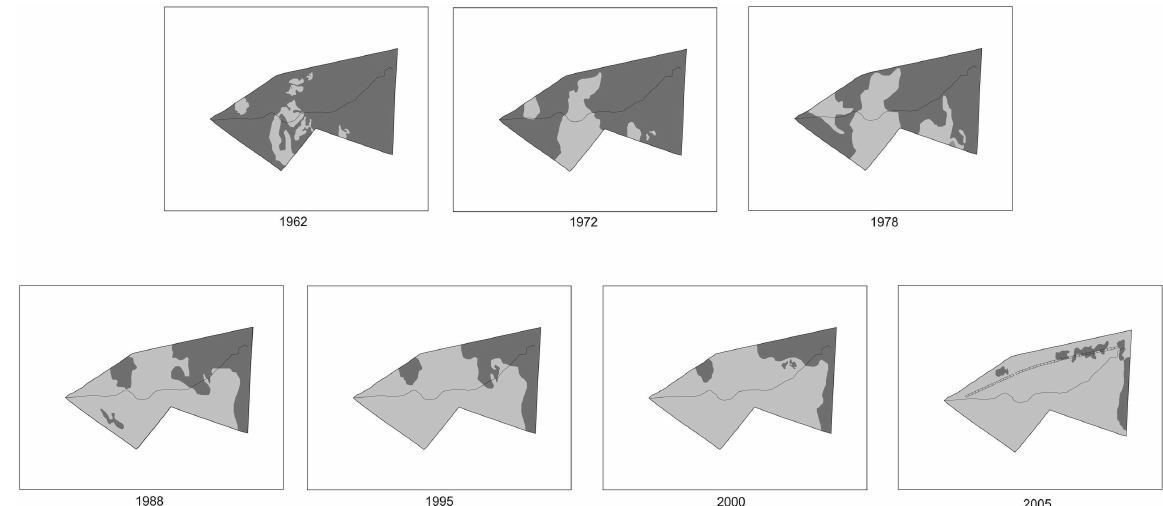
Fig. 3 – Space-temporal variations in both cerradão and cerrado s.s. physiognomies over 43 years. Light gray = cerradão ; dark gray = cerrado s.s.